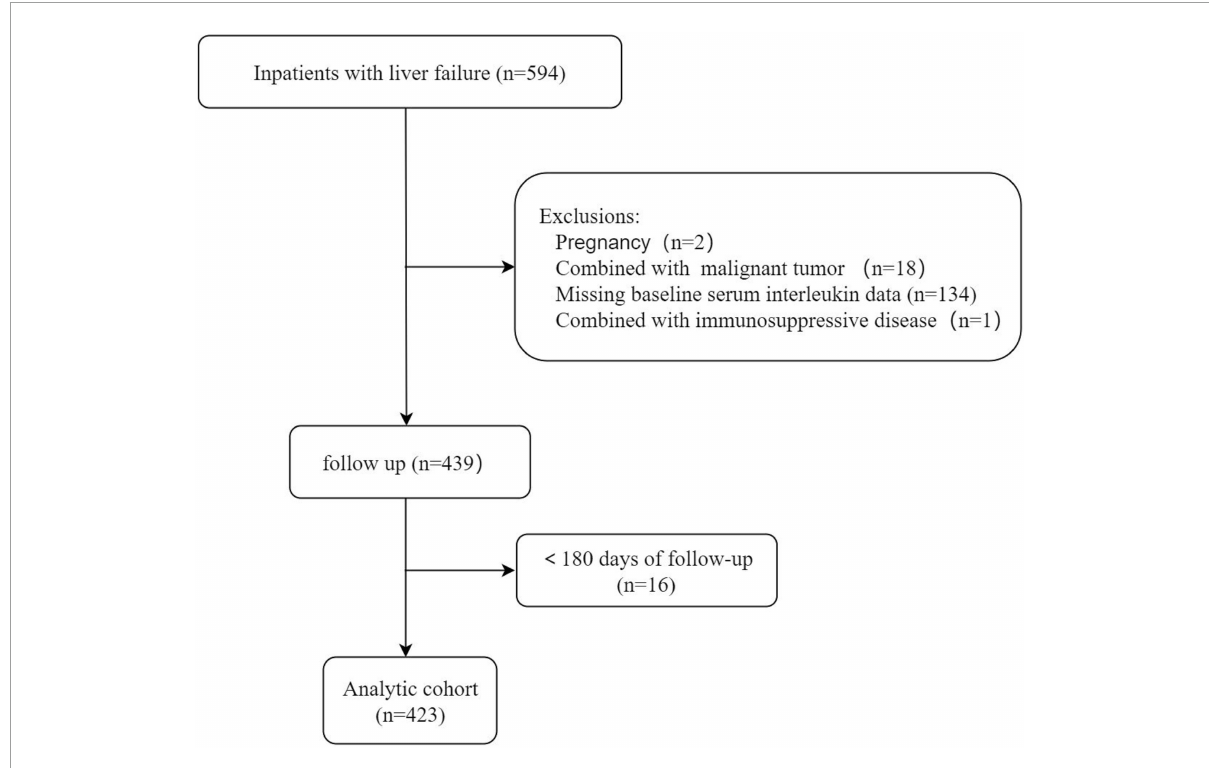
FIGURE1 Patient selection